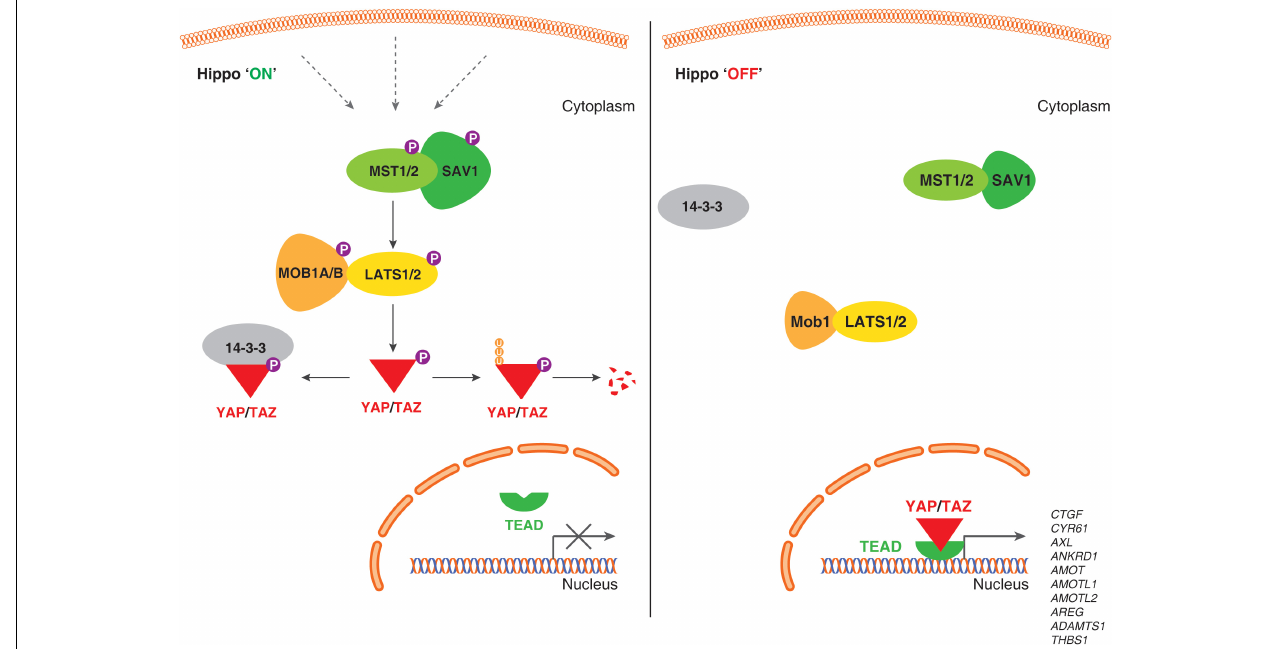
FIGURE 1 | Schematic representation of the Hippo signaling pathway-YAP/TAZ in human endothelial cells. When the Hippo signaling pathway is active/on (Left) , multiple upstream signals regulate the phosphorylation of MST1/MST2, LATS1/LATS2 kinases, and phosphorylates YAP/TAZ proteins. Phosphorylation of YAP/TAZ recruits 14-3-3 proteins that stimulate cytoplasmic retention or proteolytic degradation. When Hippo signaling pathway is inactive/off (Right) , YAP/TAZ are not phosphorylated, localize to the nucleus, form a complex with transcription factor TEADs and regulate genes required for endothelial cell proliferation, migration and